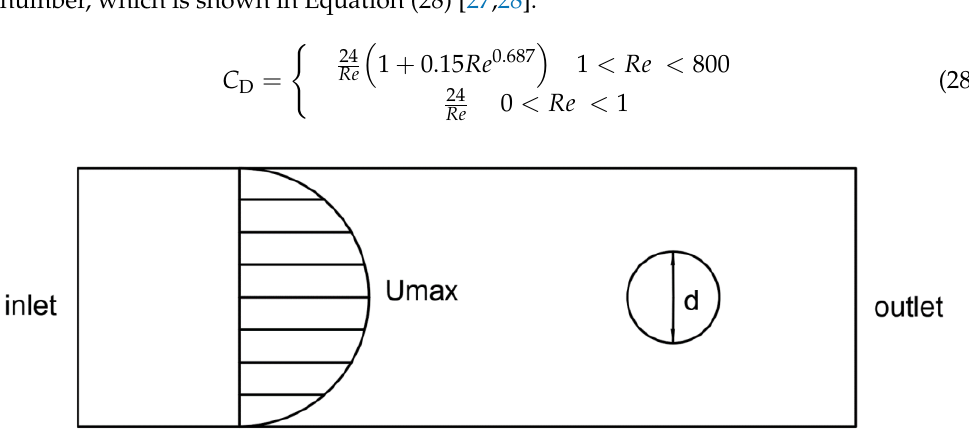
Figure 9. Comparison of analytical solution and proposed solution at x = 30.